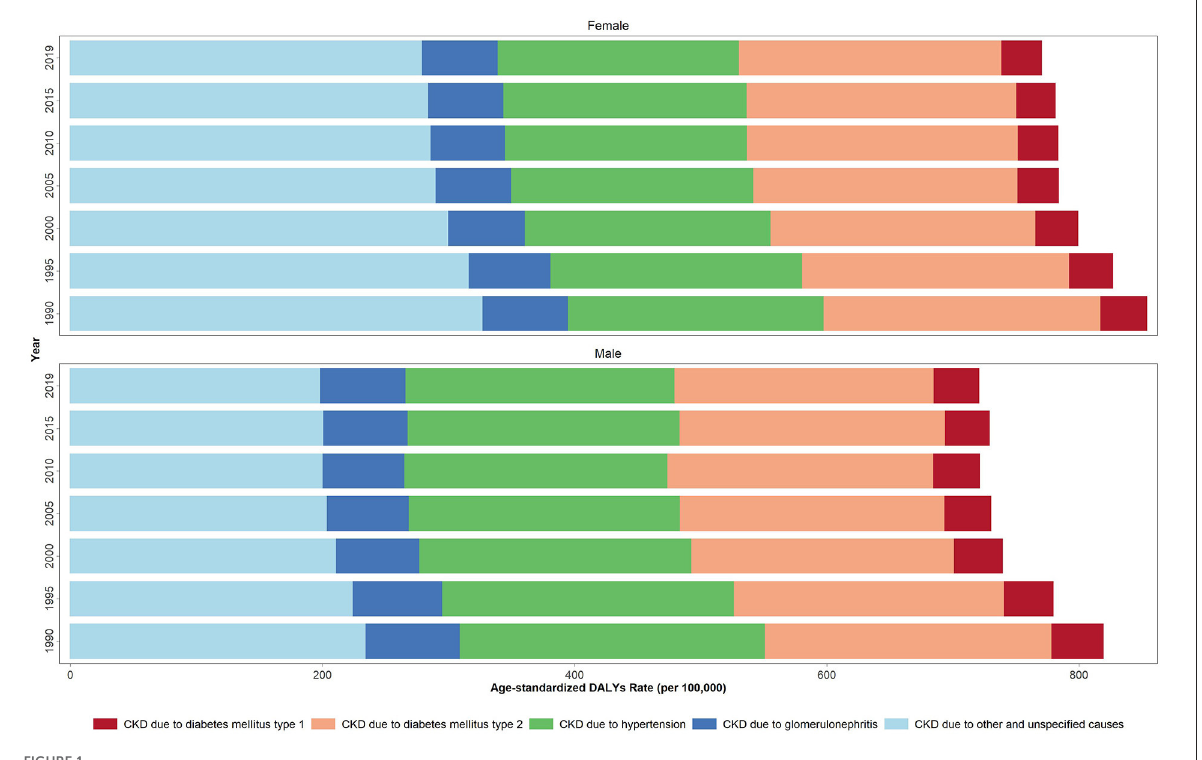
increased during the past 30 years (48.8%) (Table 3).